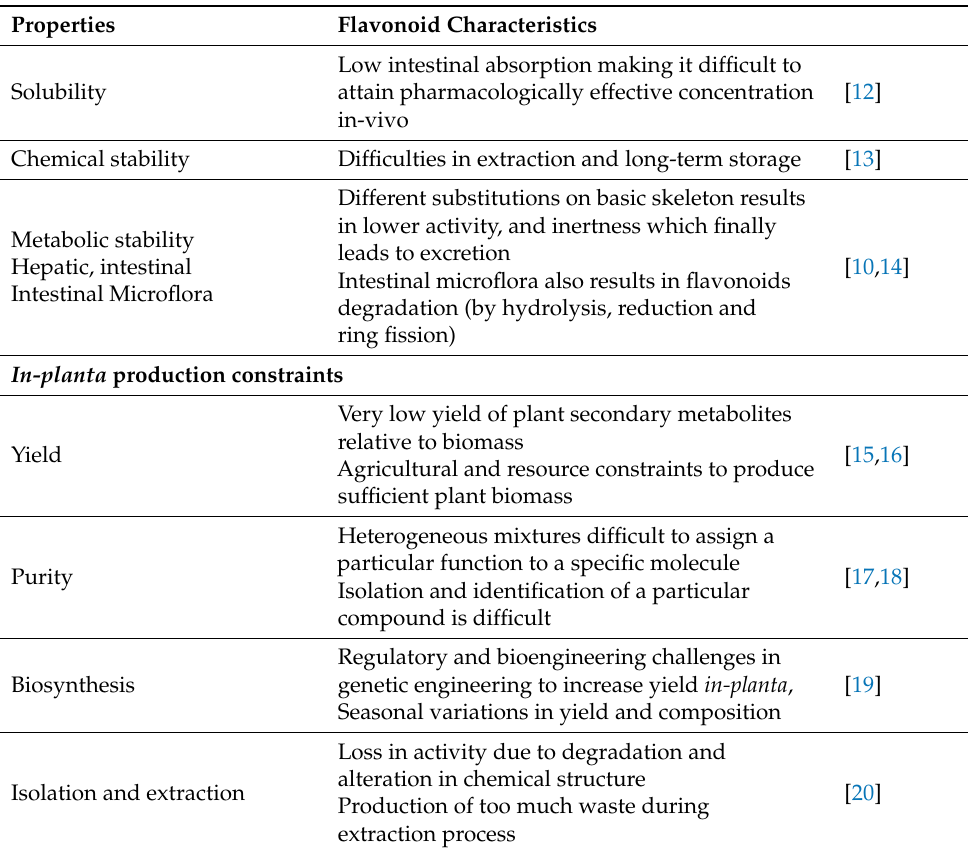
Table 1. Chemical and biophysical properties, and challenges of flavonoids in planta production. Table 2. Examples of de novo flavonoids biosynthesis in